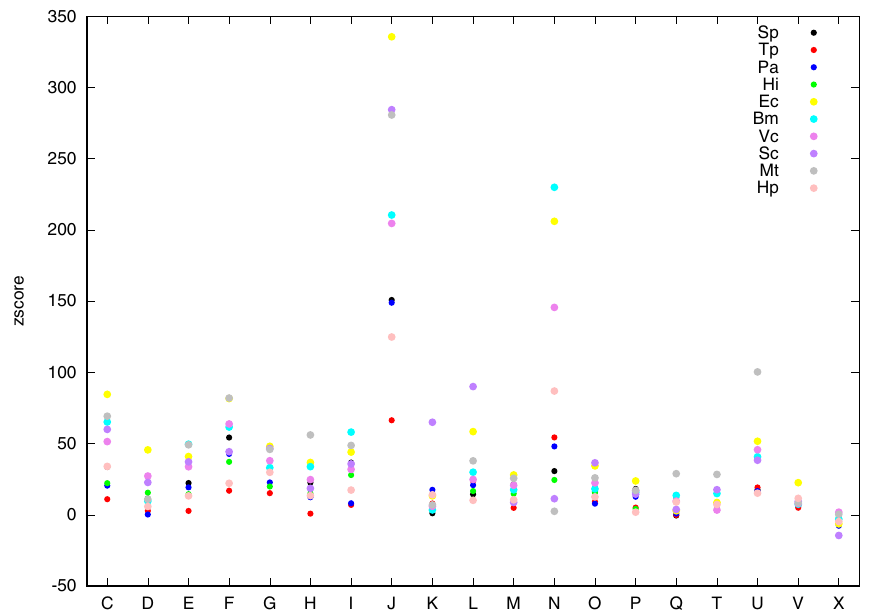
Figure 2. z -score intra-community density values (diagonal entries of Z ) of each functional class ( x -axis) are reported in different colors (each color representing a different organism as indicated in the top right legend of the plot).